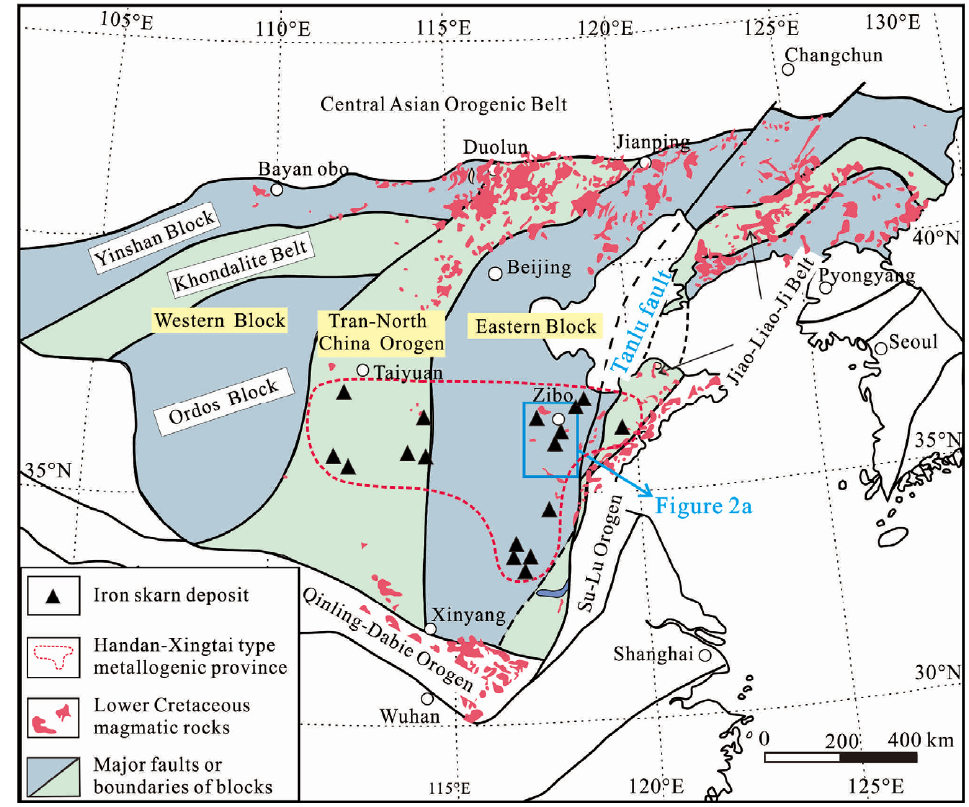
Figure 1. Tectonic sketch map of the North China Craton (modified from Zhao [16]), and distribution of iron skarn deposits (modified from Zhao et al. [2]) and Lower Cretaceous magmatic rocks (modified from Zhang et al. [17]).